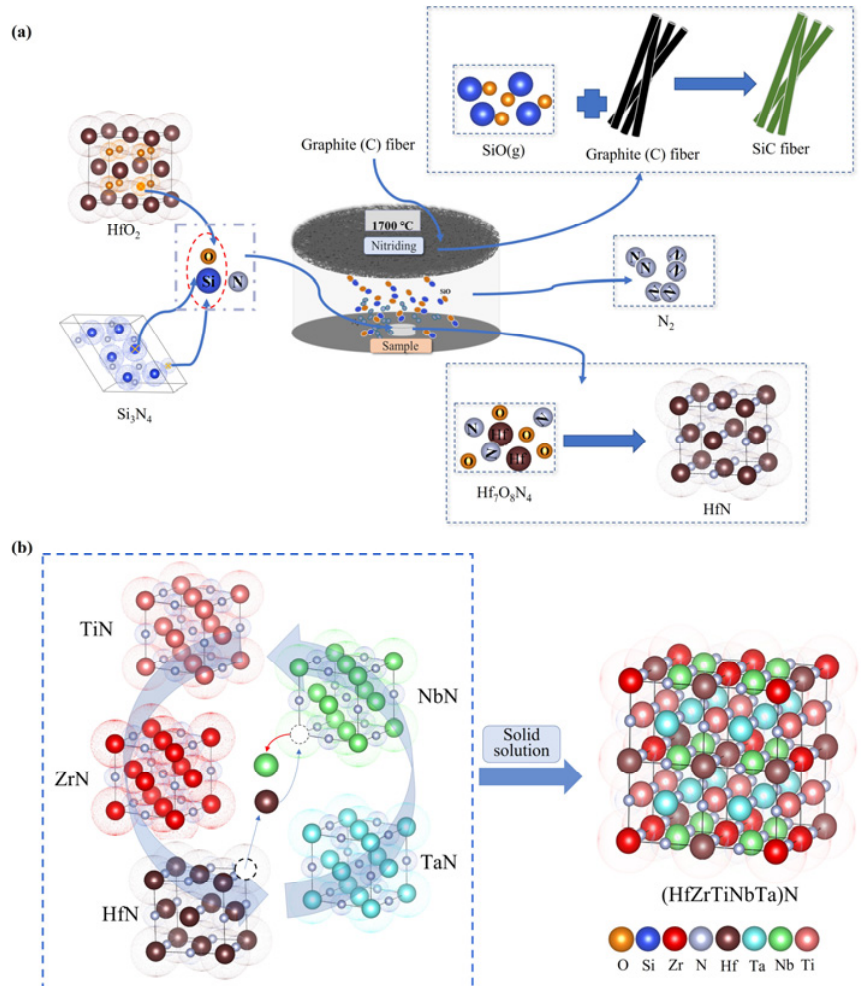
Fig. 9 Diagrammatic sketch of synthesis mechanism of nitride thermal reduction: (a) formation of HfN from HfO 2 and Si 3 N 4 ; (b) the mechanism of mutual solid solutions among metal